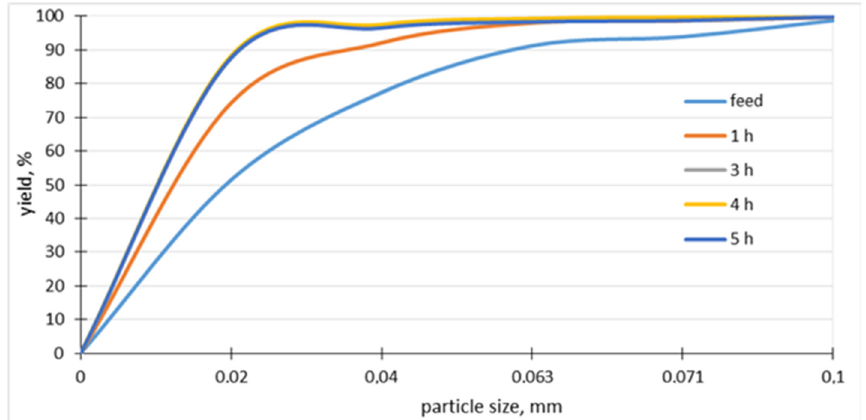
Figure 2. Grain composition curves of feed and grinding samples obtained with analytical sieves on wet method.